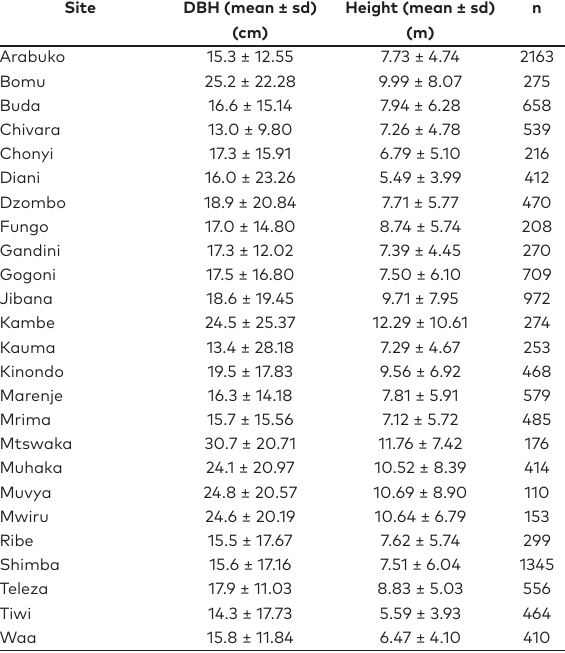
Table 4. Basic structural data of the Kenyan coastal for- est sites expressed as mean (± standard deviation) of the DBH and height, and number of measured trees